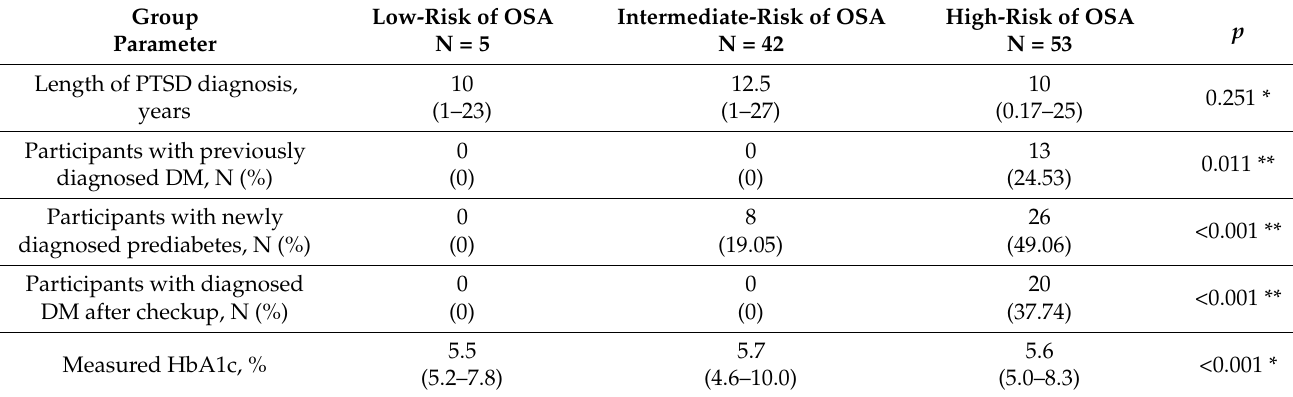
Table 3. Distribution of participants according to OSA risk stratification and diagnosis of